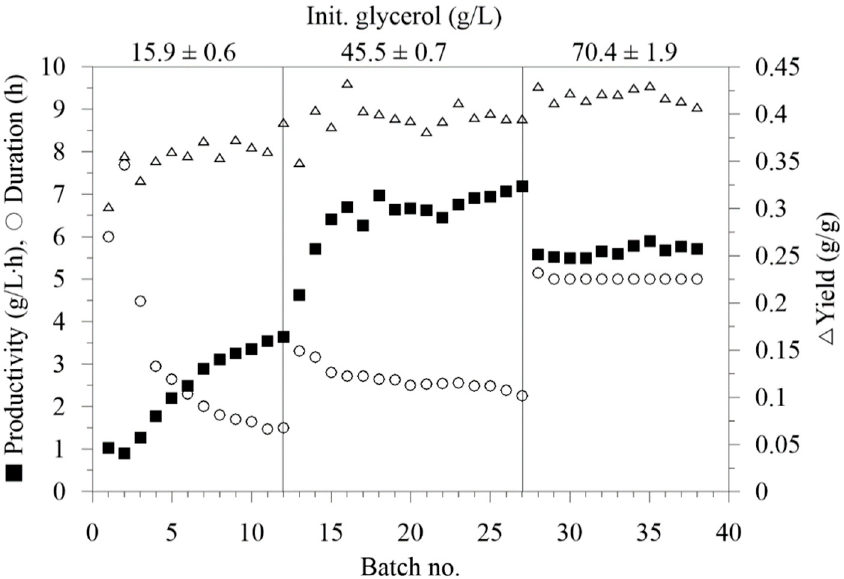
Figure 1. Productivity, yield and duration of fermentation, in consecutive repeated batches, with different initial concentrations of pure glycerol. di ff erent initial concentrations of pure